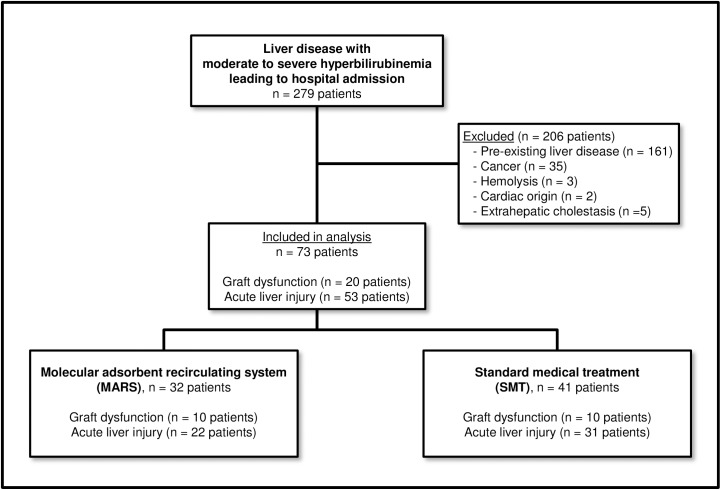
Flow chart displaying the selection procedure and patient numbers.All patients with moderate to severe hyperbilirubinemia (≥ 6 mg/dL) leading to a hospital admission between January 2009 and June 2015 were screened for acute liver injury or graft dysfunction. All patients in the final cohort received either SMT (41 patients) or SMT and MARS (32 patients).